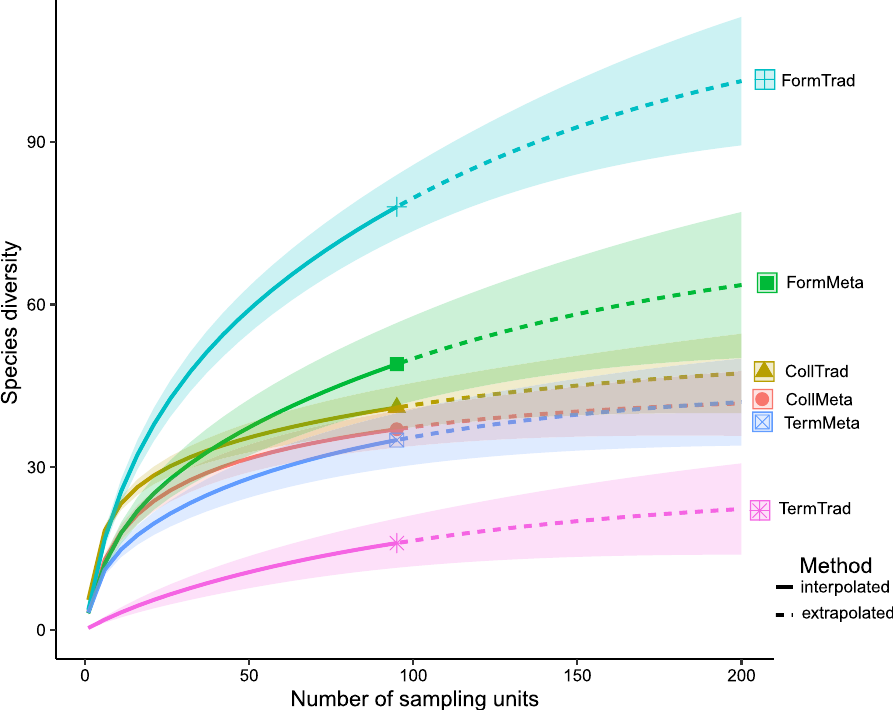
Figure 2. Accumulation of species richness vs. the number of samples for ants, springtails and termites, detailed for traditional and metabarcoding samples. CollMeta, CollTrad = Collembola in metabarcoding and traditional samples; FormMeta, FormTrad = Formicidae in metabarcoding and traditional samples; TermMeta, TermTrad = termites in metabarcoding and traditional samples. The graphic was created with iNext 2.0.20 https:// cran.r- proje ct. org/ web/ packa ges/ iNEXT/ index. html 61